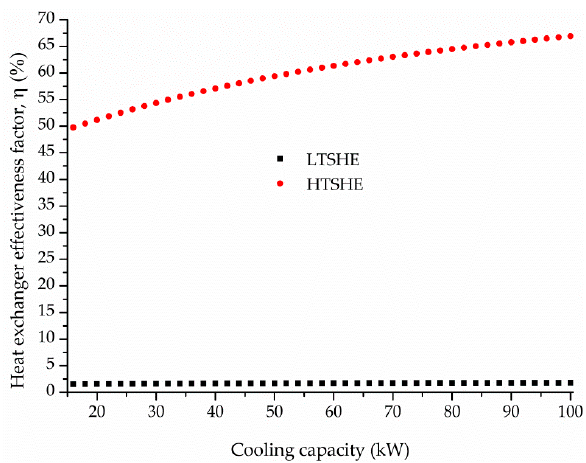
Figure 7. Optimal effectiveness factors η of the low-temperature solution heat exchanger (LTSHE) and the high-temperature solution heat exchanger (HTSHE) versus the cooling capacity when their lower bounds η LB are relaxed.